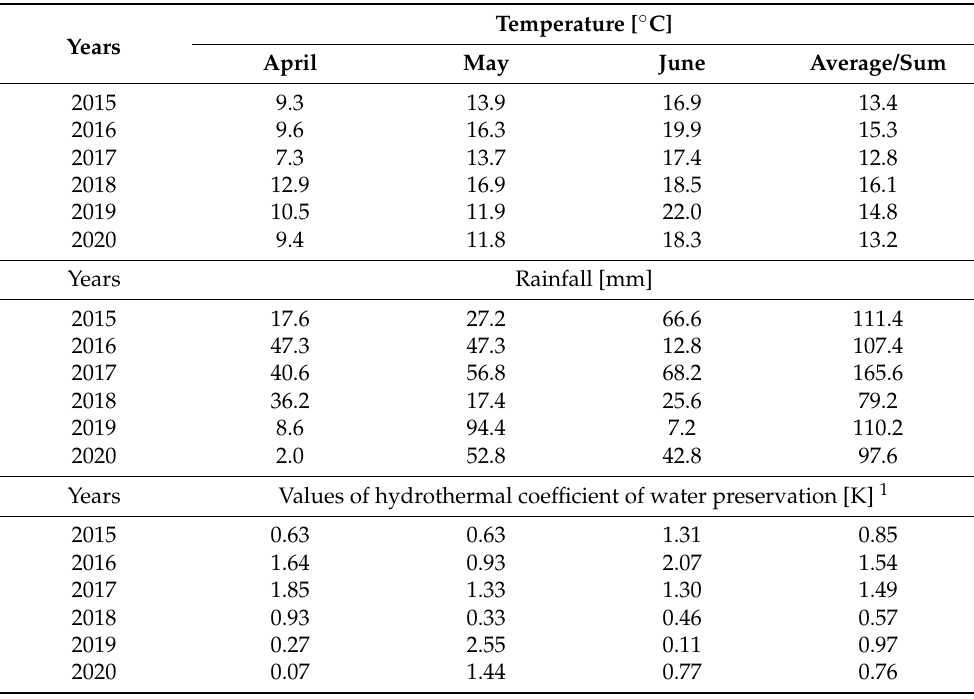
Table 2. growing